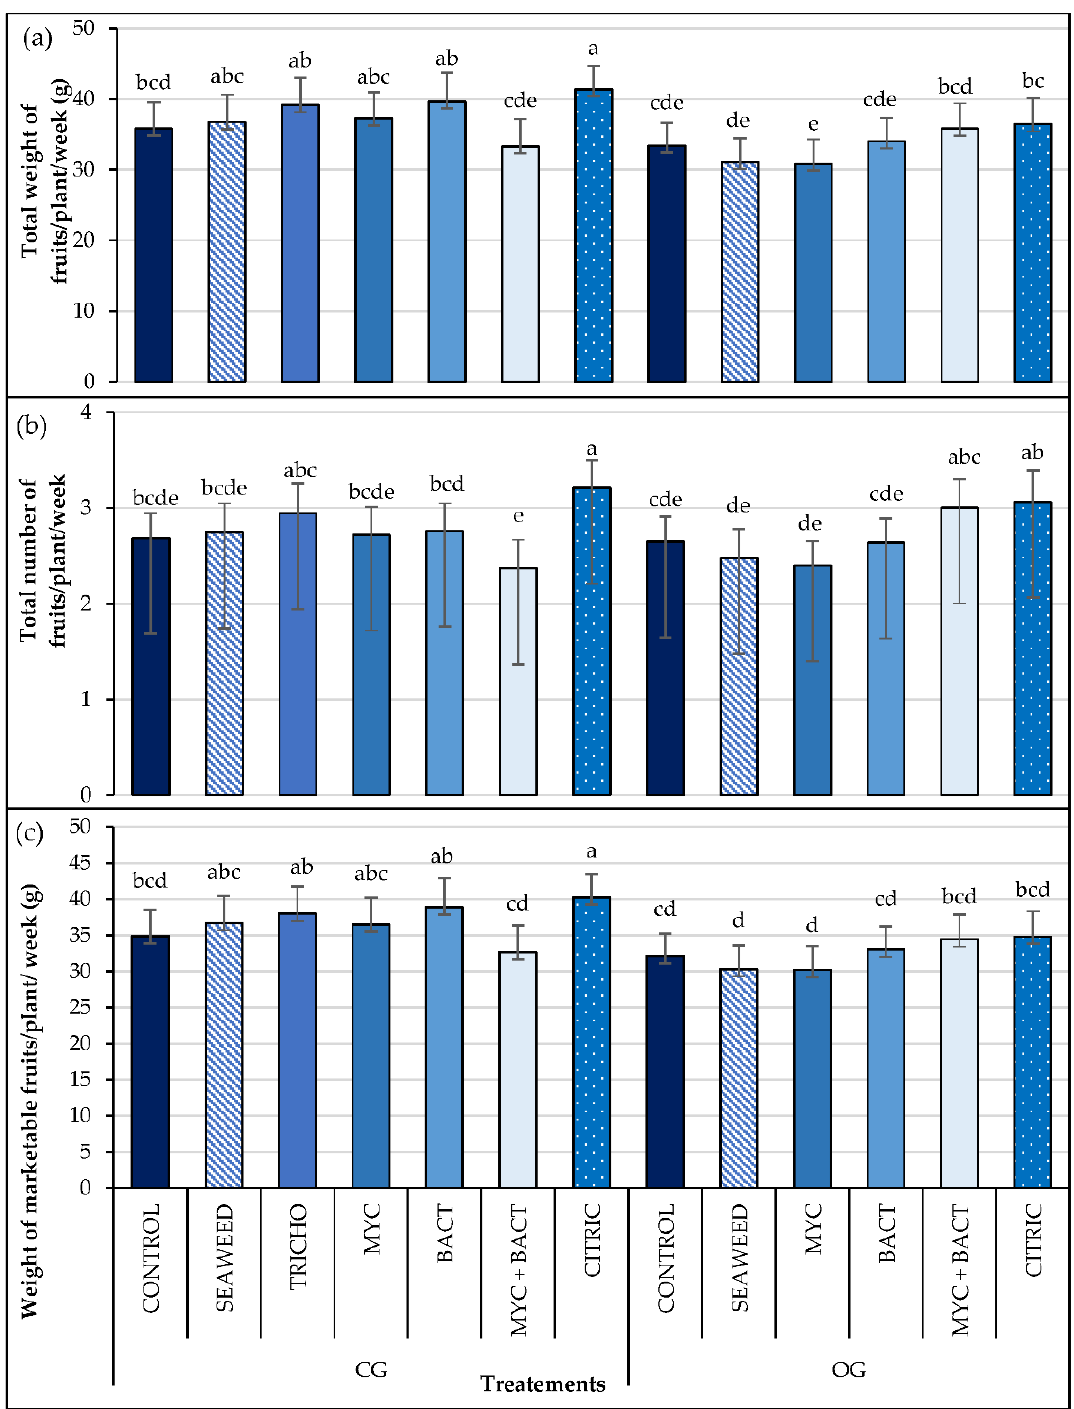
Figure 2. The influence of biostimulants and greenhouse growing systems on the total weight of fruits harvested per plant and per week ( a ), total number of harvested fruits per plant and per week ( b ), and the weight of marketable fruits harvested per plant and per week ( c ) in the greenhouse during winter 2018. Means followed by the same letter are not significantly different ( p ≤ 0.05). CG: conventional greenhouse; OG: organic greenhouse; CONTROL: without biostimulant; SEAWEED: seaweed extract; TRICHO: Trichoderma , MYC: mycorrhiza ( Rhizoglomus irregulare ); BACT: three bacteria ( Azospirillum brasilense , Gluconacetobacter diazotrophicus , and Bacillus amyloliquefaciens ); MYC + BACT: a combination of treatments MYC and BACT; CITRIC: citric